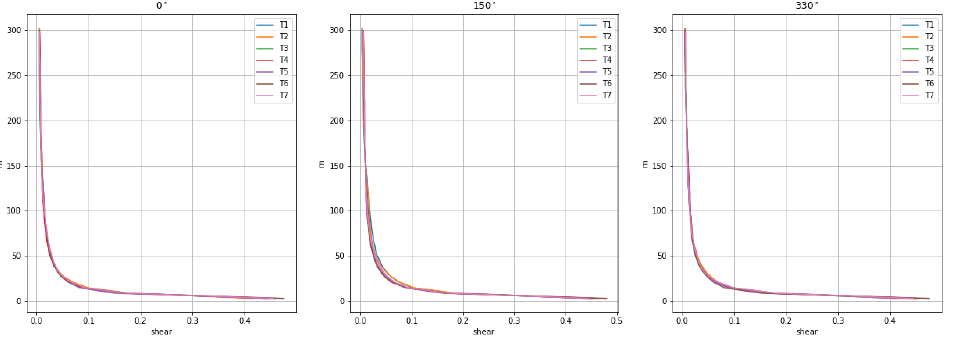
Figure 7. Wind shear profile for the 0 ◦ , 150 ◦ , and 330 ◦ direction sectors.